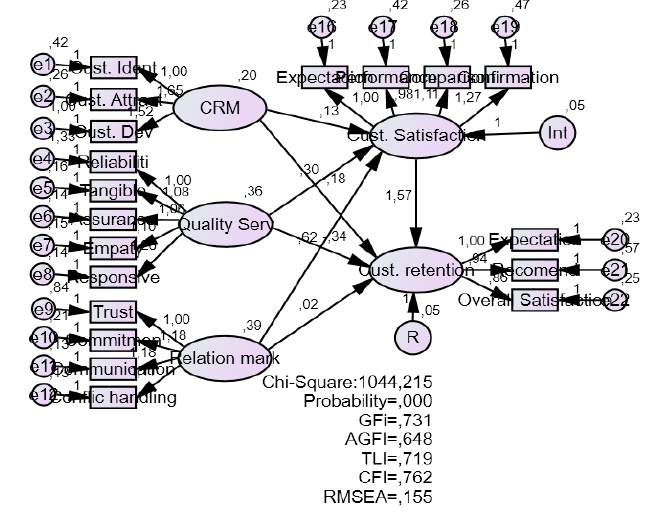
Fig. 5. Model Equation